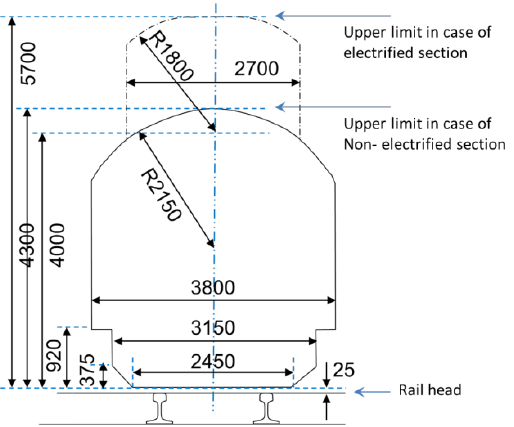
Figure 3. Track center, gauge and cross level Figure. 1 The clearance gauge of a conventional line in JR-West 3.2 Automatic clearance check Detection of objects inside the clearance gauge is executed by fitting the virtual frame of the clearance gauge to the 3-D point cloud space. The position of the clearance gauge is automatically derived from track center line extracted by the method of Section 3.1 and checking the presence or absence of points in the